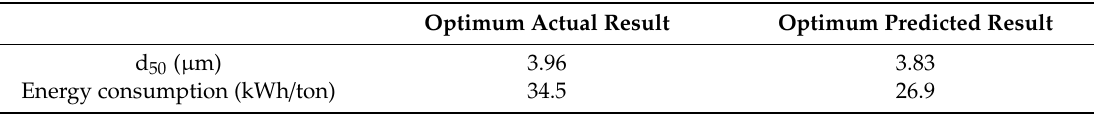
(Table 5) [36]. The optimization of energy consumption as a result of detecting operational parameters for the stirred media mill is crucial. Table 5. Comparing the optimum actual and predicted result. Table 5. Comparing the optimum actual and predicted result.